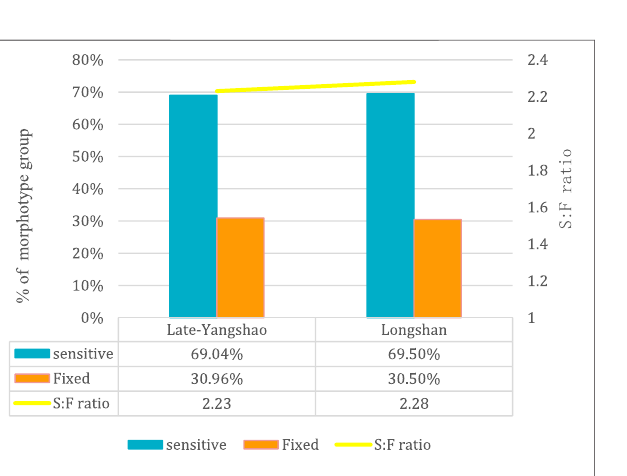
Frontiers in Earth Science |